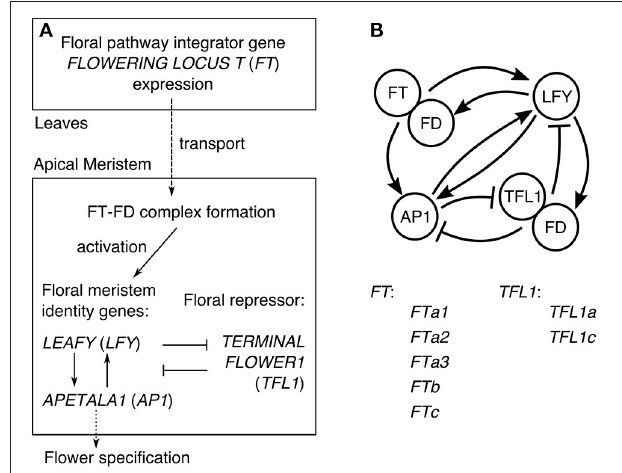
FIGURE 1 | The core gene network controlling floral transition. (A) The general scheme of processes involved in floral transition. (B) The graph of the regulatory interactions proposed for Arabidopsis, and the list of the FT and TFL1 homologs in chickpea considered in our model. The interaction graph was adopted from ( Jaeger et al.,